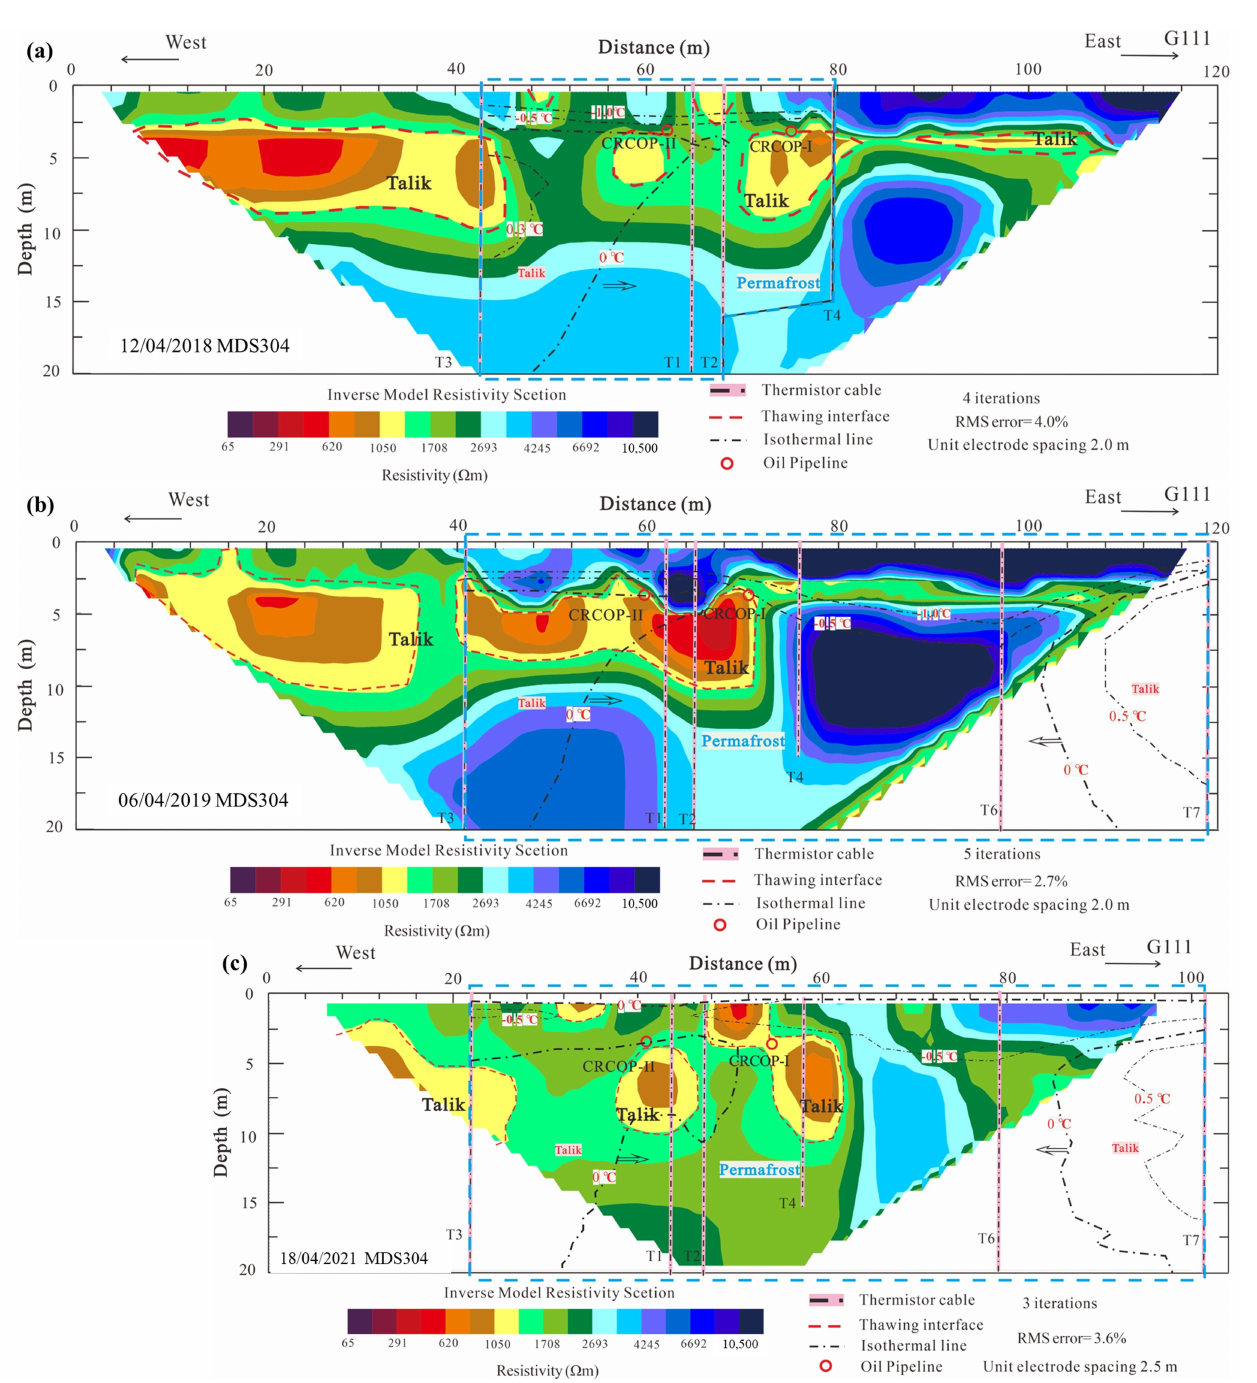
Figure 14. The correspondence between the ERT inversion profile and the cross-sectional isotherm profile of Profile 1 of the MDS304 site on 12 April 2018 ( a ), 6 April 2019 ( b ), and 18 April 2021 ( c ). Note: a blue dashed frame indicates the combination of an ERT inversion profile and an isotherm. T1, . . . , T7 is a ground temperature borehole. The red circle represents the oil pipeline, and CRCOP-II and CRCOP-I are distributed sequentially from west to